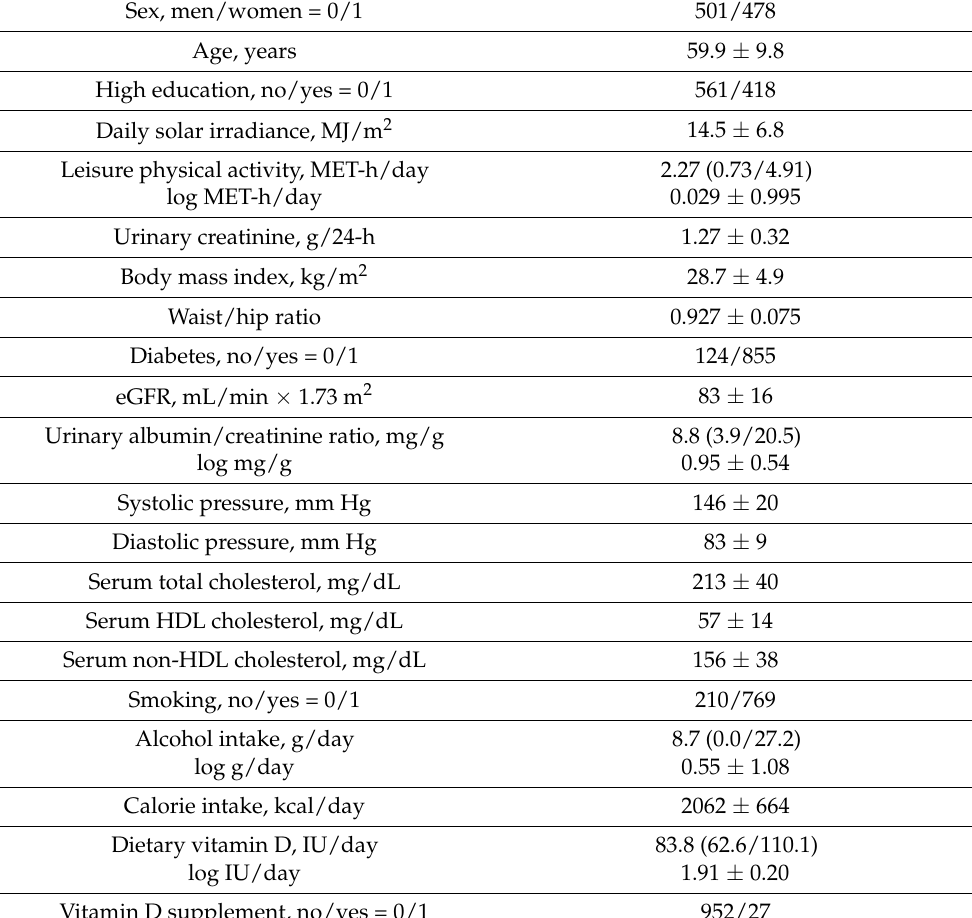
Table 1. Descriptive statistics: prevalence for categorical variables, median (IQR) for skewed variables (skewness > 1), and mean ± SD for non-skewed variables and log-transformed skewed variables. Sex, men/women =